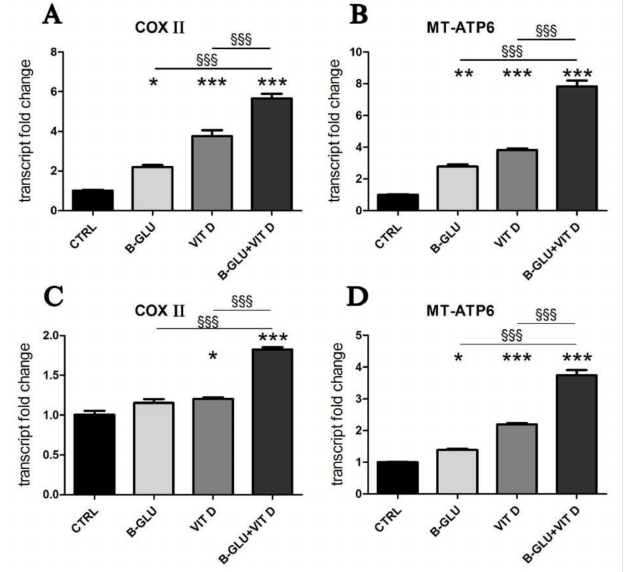
Figure 4. Vitamin D and beta-glucans stimulate the transcription of mitochondrial OXPHOS com- ponents. The two cell lines were differentiated to macrophages by TPA treatment. After 24 h of treatment with 100 µ g/mL beta-glucans (B-GLU) and 100 nM vitamin D (VIT D), the transcript levels of cytochrome C oxidase subunit 2 (COX II) and mitochondrial ATP synthase F0 subunit 6 (MT-ATP6) were measured by real-time PCR. ( A,B ) Differentiated U-937 cells; ( C,D ) differentiated THP-1 cells. Results are means ± SEM. * P < 0.05 and *** P < 0.001 vs. ctrl; § §§ P <